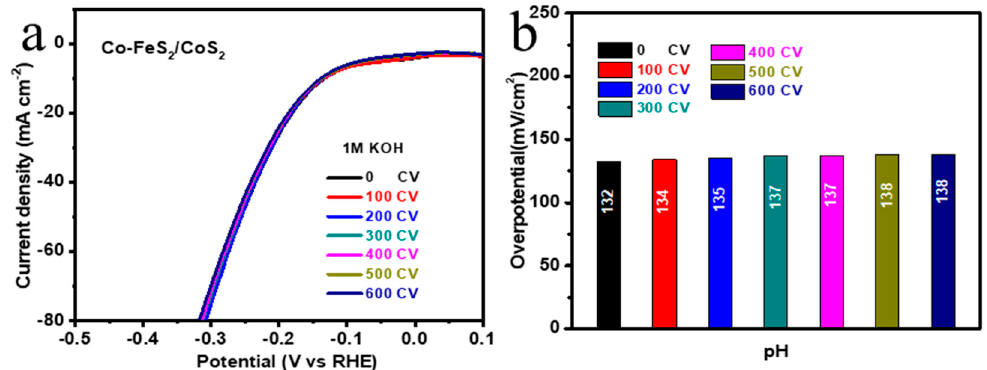
Figure 4. ( a ) LSV curve of Co-FeS 2 /CoS 2 heterostructure after 0 to 600 CV cycles; ( b ) Histogram corresponding to the overpotential of the LSV curve of the Co-FeS 2 /CoS 2 heterostructure at 10 mV cm − 2 after 0 to 600 CV cycles in figure a.